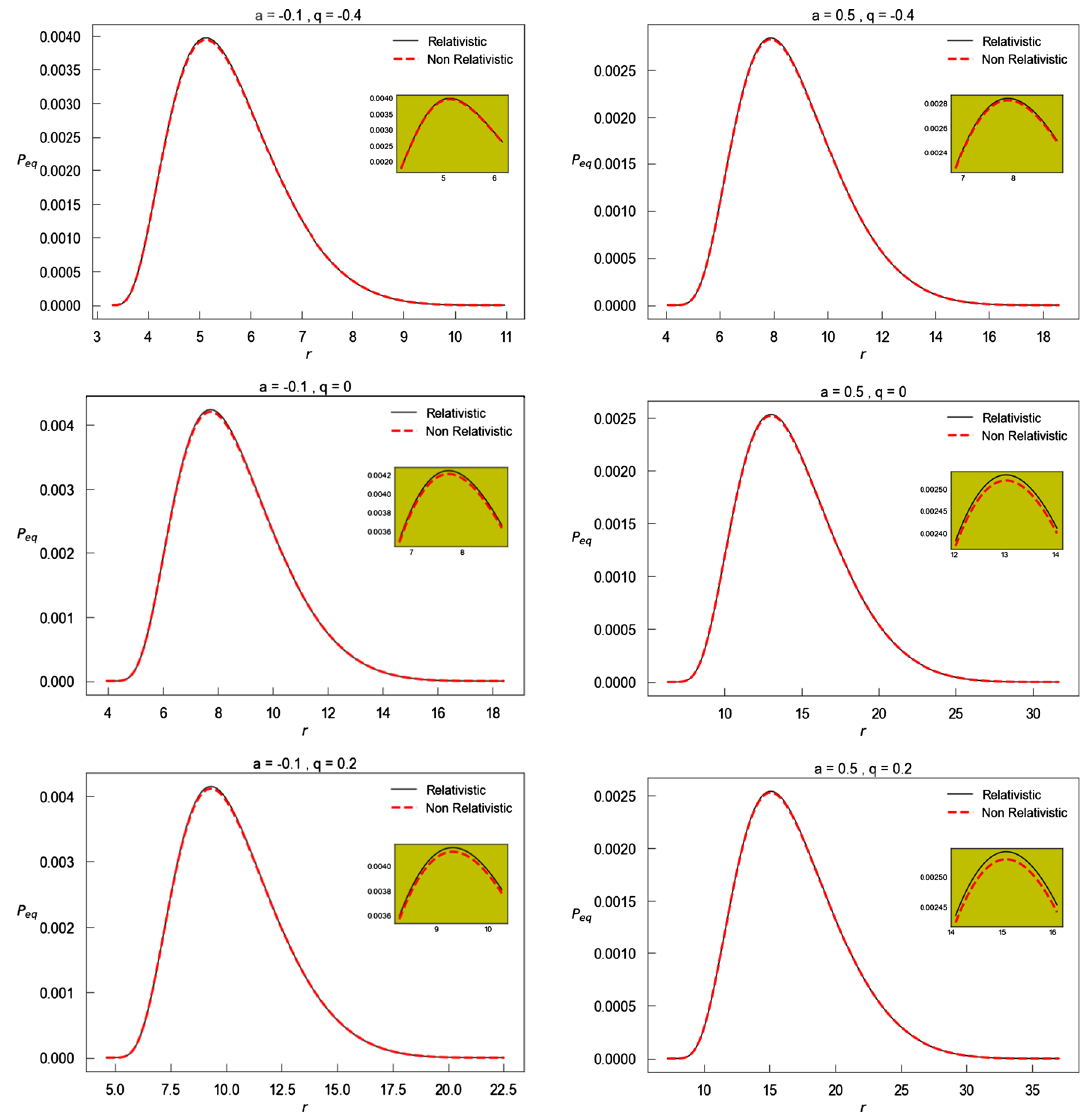
Fig. 10 Pressure profile on the equatorial plane comparing the relativistic and the non-relativistic